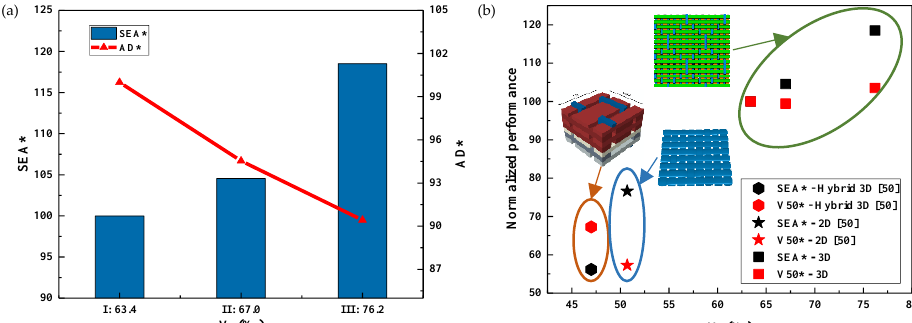
Figure 6. Experimental results of impact tests: ( a ) relationship between normalized performance (SEA* and AD*) and V f ; ( b ) relationship between normalized performance (V50* and SEA*) and V f . (Note: V50*, SEA* and AD* are normalized with the corresponding values of sample I.) [50].